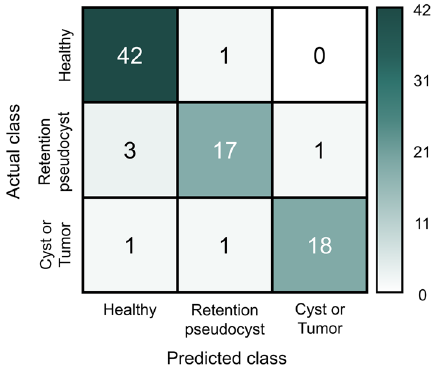
Figure 2. Classification matrix of the test dataset.